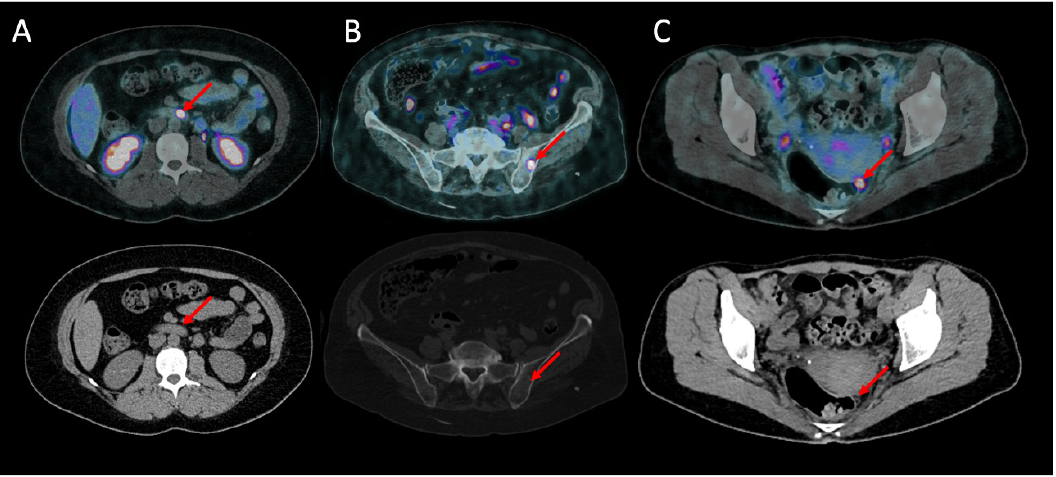
Figure 1. Additional lesions detected by 68Ga-DOTANOC (upper: fusion pET and CT images; lower: CT scan). ( A ) Primary lesion: grade 2 duodenal gastrinoma in a 35-year-old female. ( B ) Bone metastasis in a 50-year-old female with a grade 1 intestinal NET. ( C ) Peritoneal carcinomatosis in a 79-year-old female with a grade 2 intestinal NET.